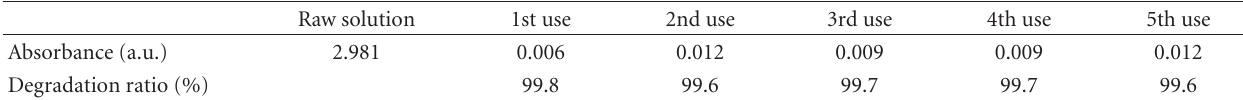
Table 4: Degradation rates of the MB over the mesoporous BiVO 4 nanorods.